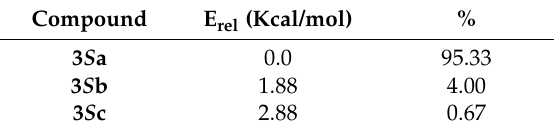
Figure 6. Rotamers for 3 S . Table 3. Boltzmann population for rotamers of 3 S .